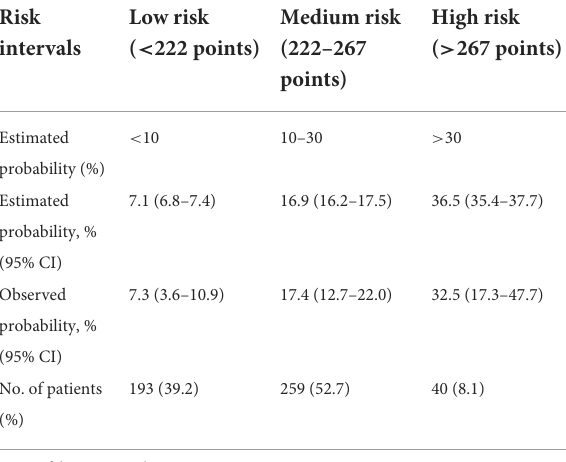
TABLE 3 Risk intervals of reintubation based on the nomogram and clinical